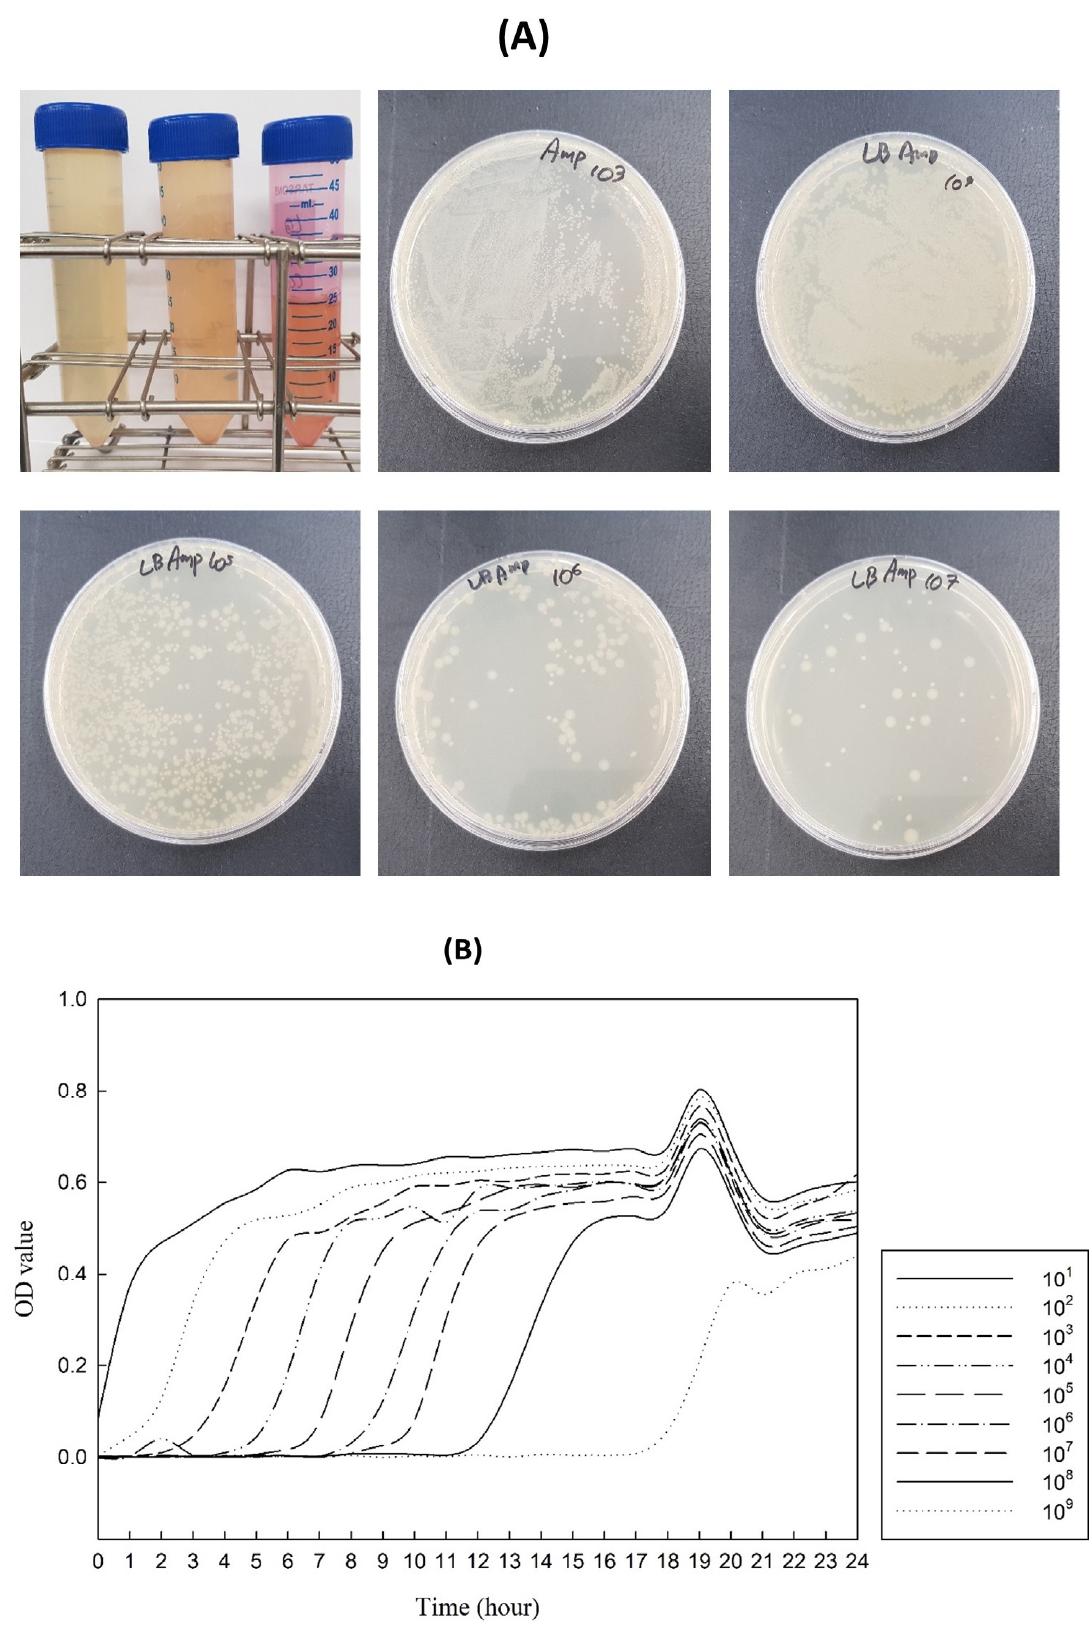
Figure 5. ( A ) E. coli culture containing pBHA bacteria proliferated in LB medium containing ampi- cillin. ( B ) E. coli growth curve in an ampicillin-containing medium.